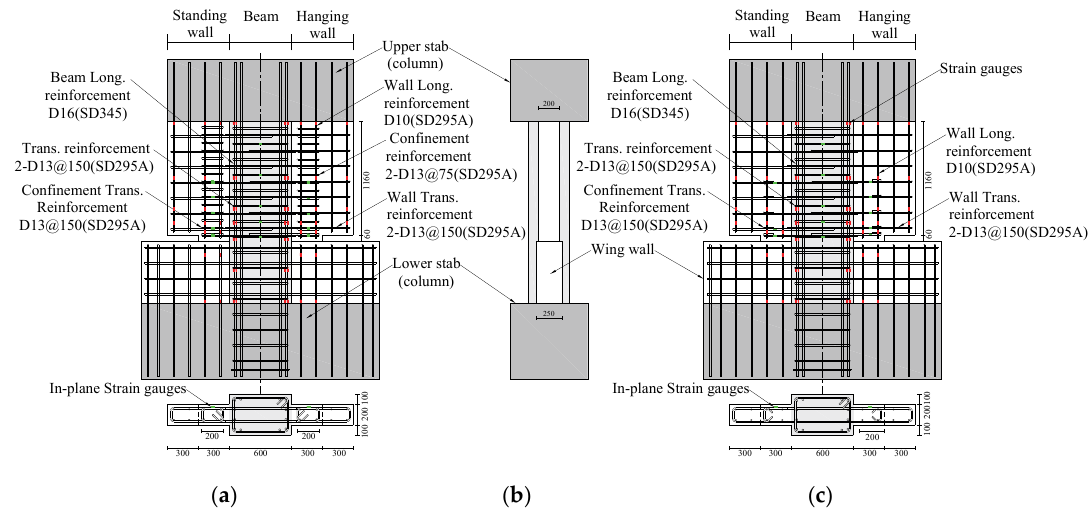
Figure 2. Geometry of specimen; ( a ) in-plane view of BSH; ( b ) out of plane view of BSH and BS; ( c ) in-plane view of BS. The first letter B in BSH and BS stands for beam, S for spandrel wall and H for having confinements.